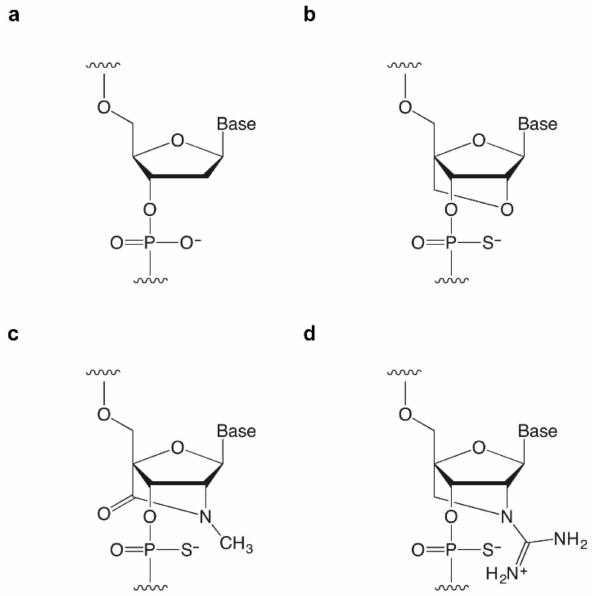
Figure 1. Structures of BNA analogs used in this study. ( a ) Deoxyribonucleic acid (DNA). ( b ) 2 (cid:48) , 4 (cid:48) - Bridged nucleic acid/locked nucleic acid (2 (cid:48) ,4 (cid:48) -BNA/LNA). ( c ) Amido-bridged nucleic acid (AmNA). ( d ) Guanidine-bridged nucleic acid